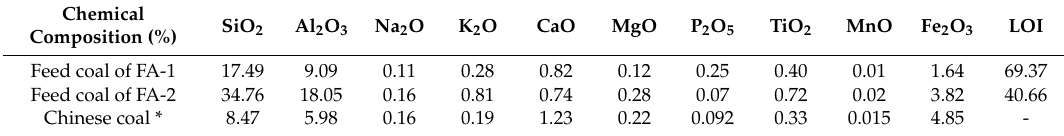
Table 2. Chemical composition of the feed coals for FA–1 and FA-2.